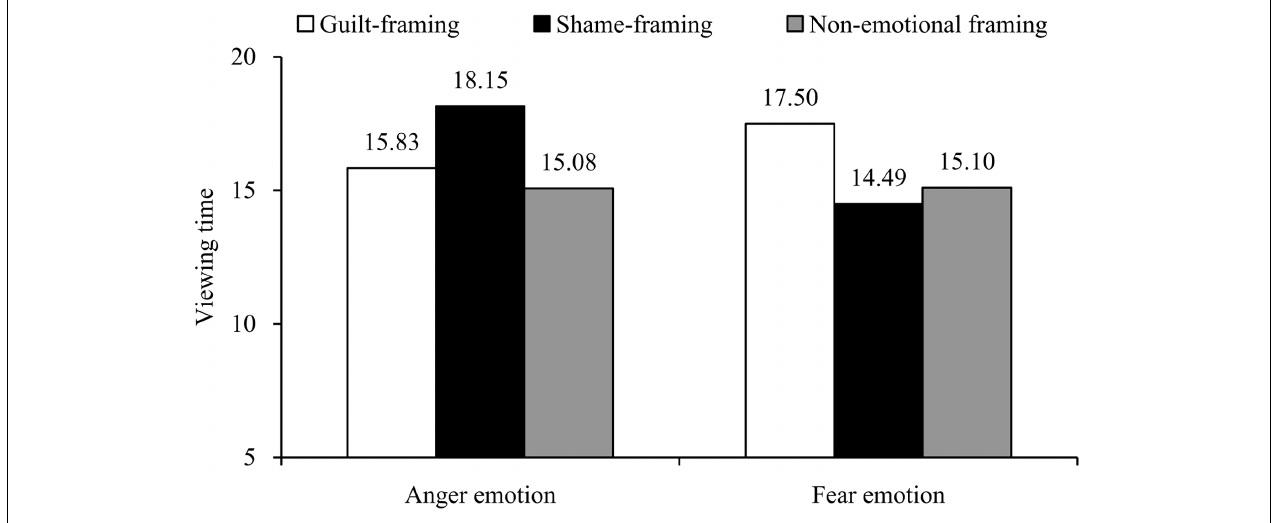
FIGURE 2 | Interaction effect of consumer emotion and company emotional frame on viewing time (Study